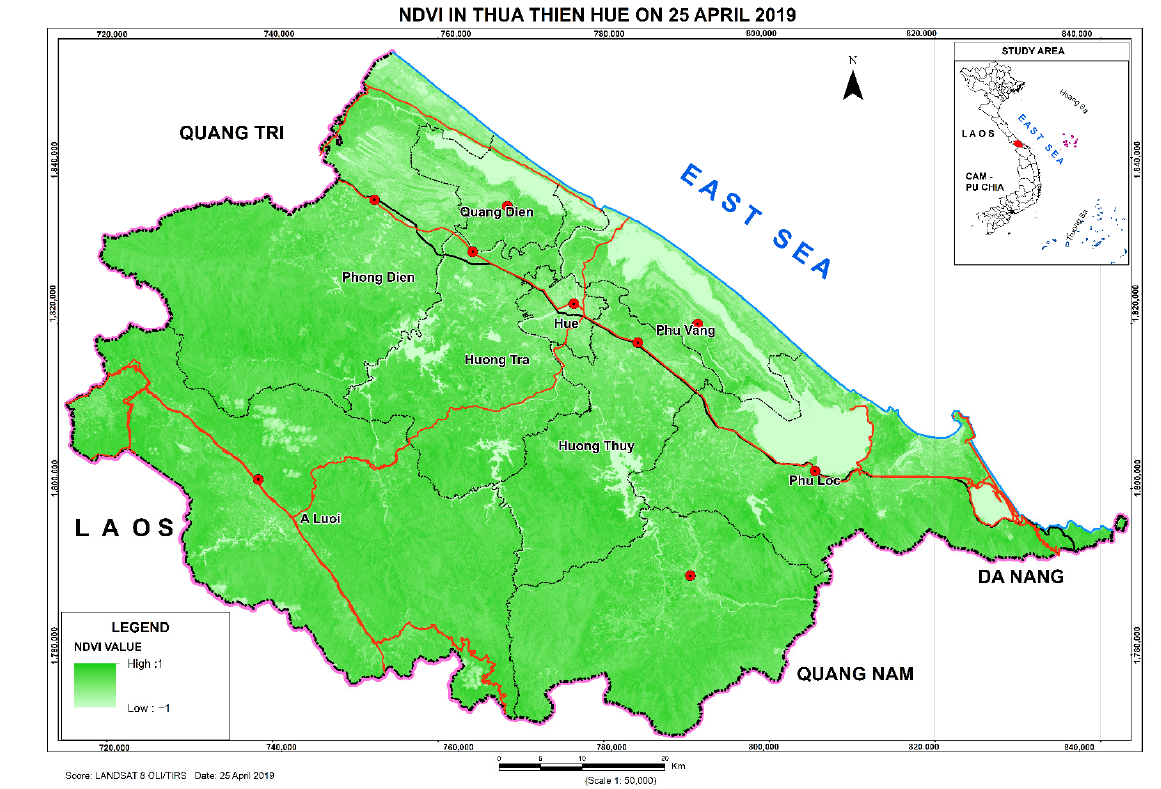
Remote Sens. 2022 , 14 , x FOR PEER REVIEW Figure 6. NDVI by Landsat 8 OLI/TIRS on 25 April 2019. Figure 6. NDVI by Landsat 8 OLI/TIRS on 25 April 2019.